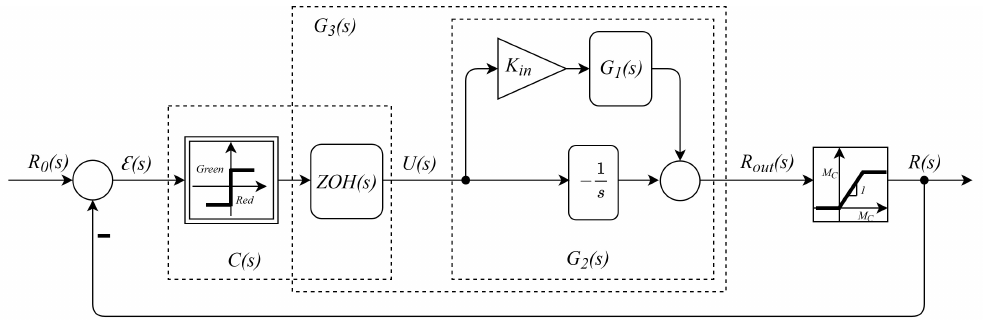
Figure 4. Traffic control system structure for a single-lane road segment.